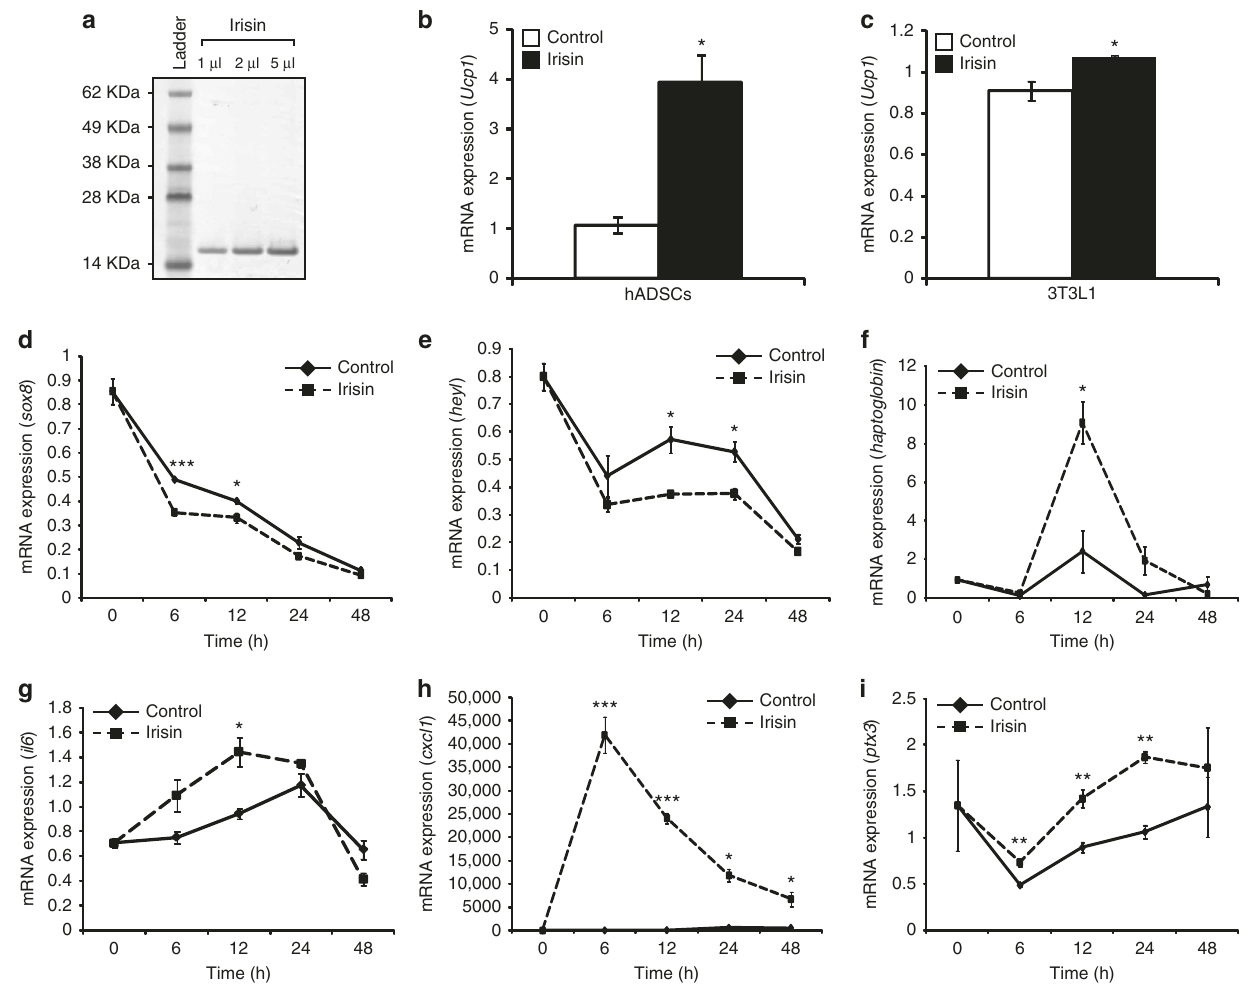
Fig. 1 Irisin induces gene expression changes and improves myogenesis. a Image of Coomassie-stained polyacrylamide gel showing recombinant His- tagged irisin protein. Recombinant irisin protein was detected as a single band at ~15 kDa. Lane 1 shows the SeeBlue Plus 2 Pre-Stained ladder. Lanes 2, 3, and 4 show 1, 2, and 5 μ l of the puri fi ed His-tagged irisin protein, respectively. b Graph representing qPCR analysis of Ucp1 expression in human subcutaneous white adipose-derived stem cells (hADSCs) after 21 days of adipogenic differentiation in the presence of DB (control) or irisin ( n = 2 biological replicates). c Graph representing qPCR analysis of Ucp1 in 3T3L1 fi broblasts after 4 days of adipogenic differentiation in the presence of DB (control) or irisin ( n = 3 biological replicates). Graphs displaying qPCR analysis of sox8 ( d ), heyL ( e ), haptoglobin ( f ), il6 ( g ), cxcl1 ( h ), and ptx3 ( i ) in 72 h- differentiated C2C12 myotubes treated with DB (control) or recombinant irisin protein for 0, 6, 12, 24, and 48 h. All qPCR graphs show gene expression normalized to gapdh ( n = 3 biological replicates). Error bars represent mean ± SEM. Student ’ s t -test was performed for b and all relevant fi gure panels between d and i , and one-way ANOVA was peformed for c . Signi fi cance is indicated with * p < 0.05, ** p < 0.01 and *** p <